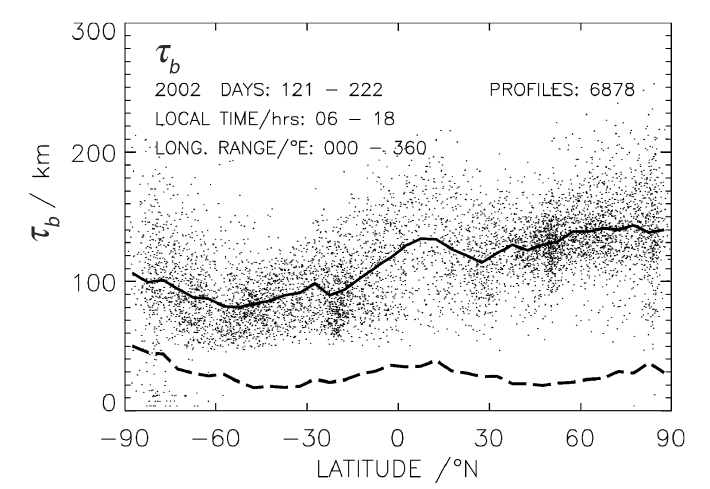
Fig. 7.12. Latitudinal distribution of the equivalent slab thickness of the bottomside ionosphere. The dashed curve represents the standard deviation.